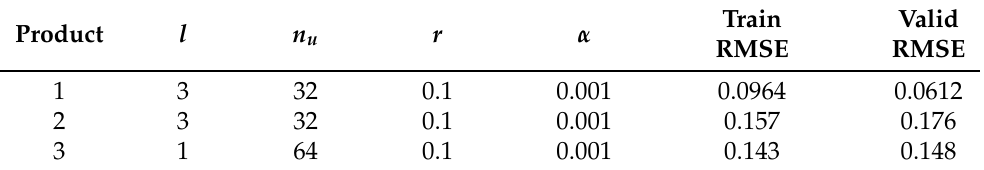
Table 7. Results of the grid search on class A (LSTM-only).